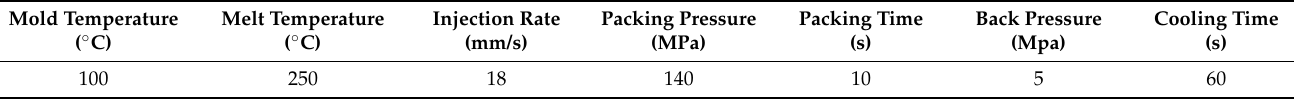
Table 2. Main process parameters for the injection molding experiment .